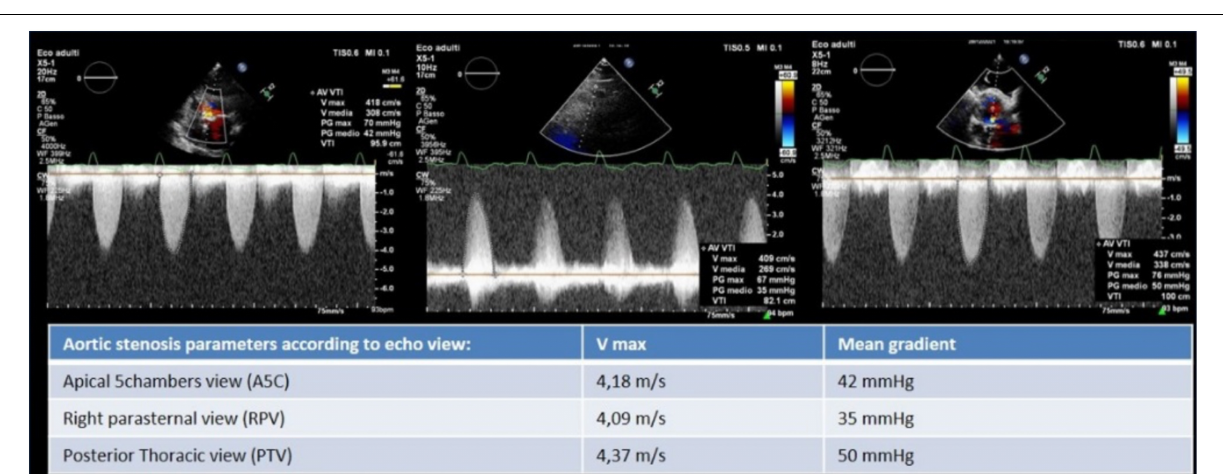
Frontiers in Cardiovascular Medicine |